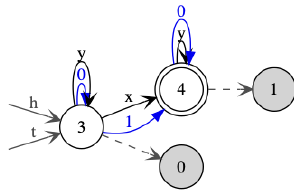
Figure 22. An equivalent dSHA to that in Figure 21 that is minimal in the class of dSHA s with equal tree and hedge initial states.